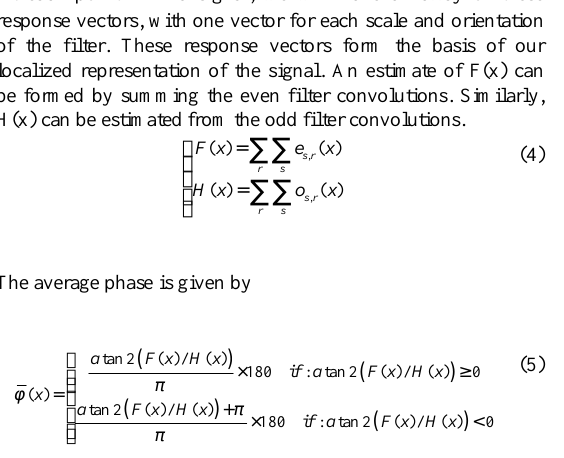
Figure 1. The results of the SIFT feature detection and matching. From top to bottom: the reference image and searching image; the results of the feature detection; the results of the feature matching after outlier